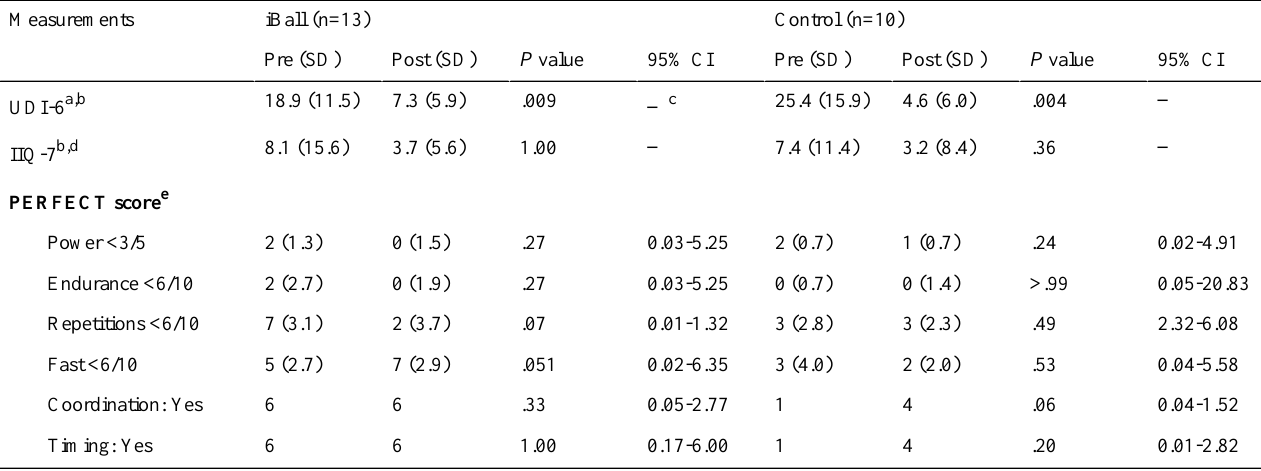
Table 5. Pre- and postintervention measurements within group